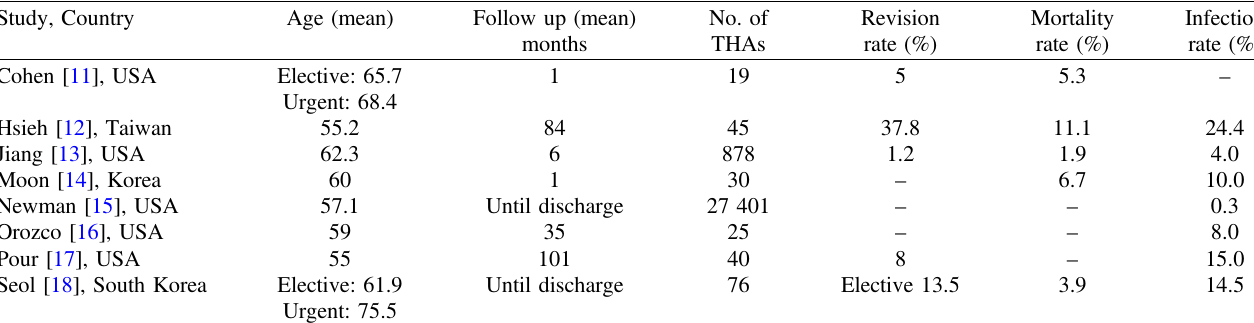
Table 1. Demographics and key fi ndings of studies included in this systematic review. Study,